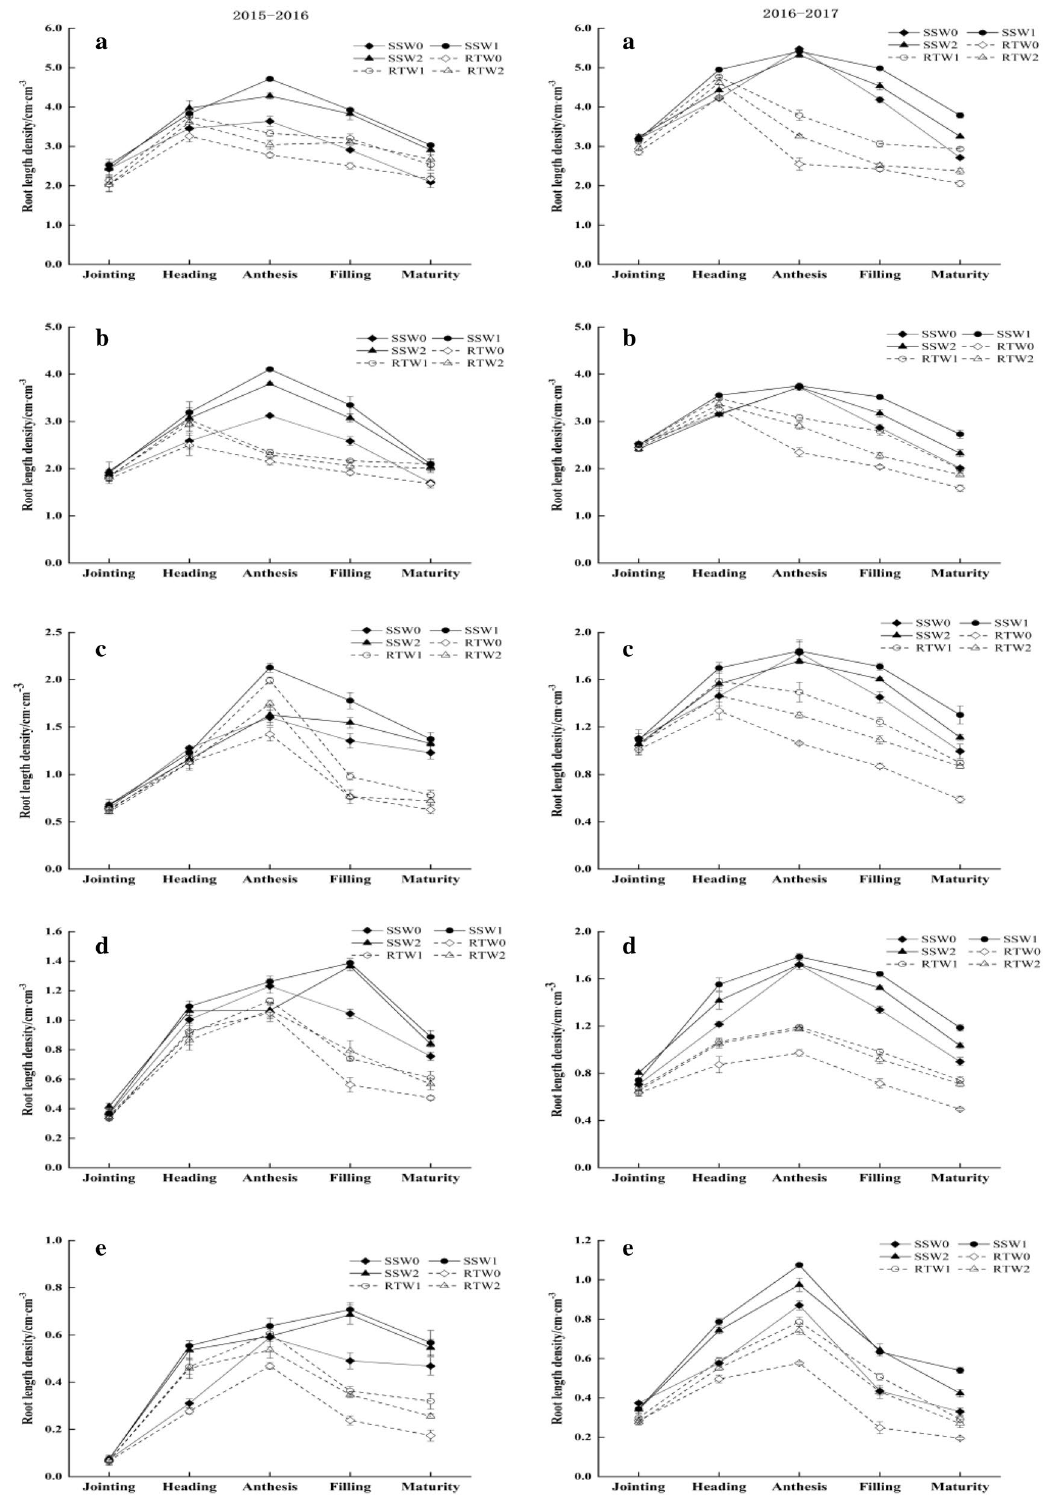
Figure 2. Effects of tillage practice and irrigation regime on the root length density of winter wheat in different soil